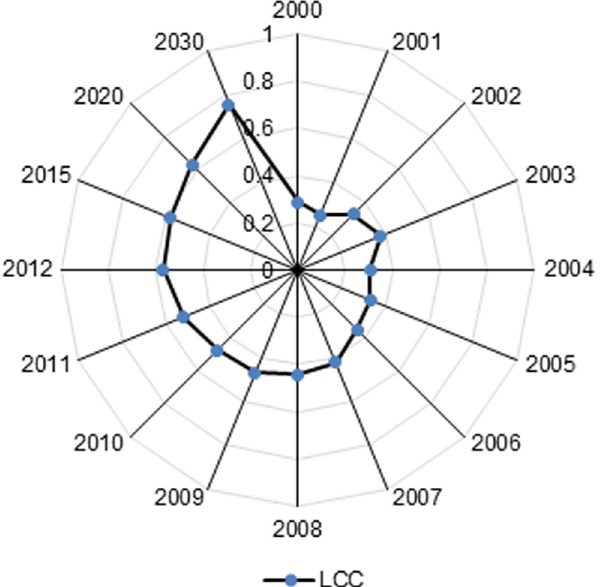
Fig 8. The integrated land carrying capacity between 2000 and 2030 in Xiamen City. LCC values calculated with ISM were used to assess the current situation and project the prospective state via linear extrapolation. The integrated value in each year also corresponds to the grading standard presented in Table